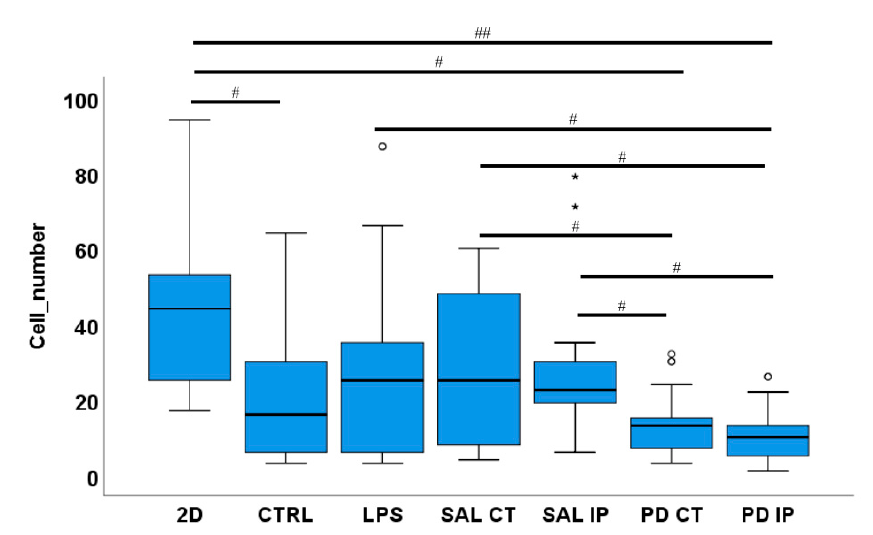
Figure 9. A low number of microglia cells were found in the repopulated matrices from the 6-OHDA-lesioned mice. Microglia cells were seeded onto the striatal decellularized matrices of the control animals (CTRL) and of the contralateral and ipsilateral hemispheres of saline and 6-OHDA-lesioned mice (SAL CT, SAL IP, PD CT, and PD IP, respectively). In addition, microglia cells were seeded onto 2D surfaces (with and without LPS stimulation). The number of microglia cells were counted after 48 h in culture. Values are shown as a box indicating the minimum, maximum, and mean values together with the SEM. Welch’s ANOVA followed by Games Howell post hoc test was performed (# p < 0.05 and ## p < 0.001). Outliers are marked with the symbols ° and *. The sampling distribution was tested for normality using the Shapiro − Wilk test and for homogeneity of variances using the Levene’s test.